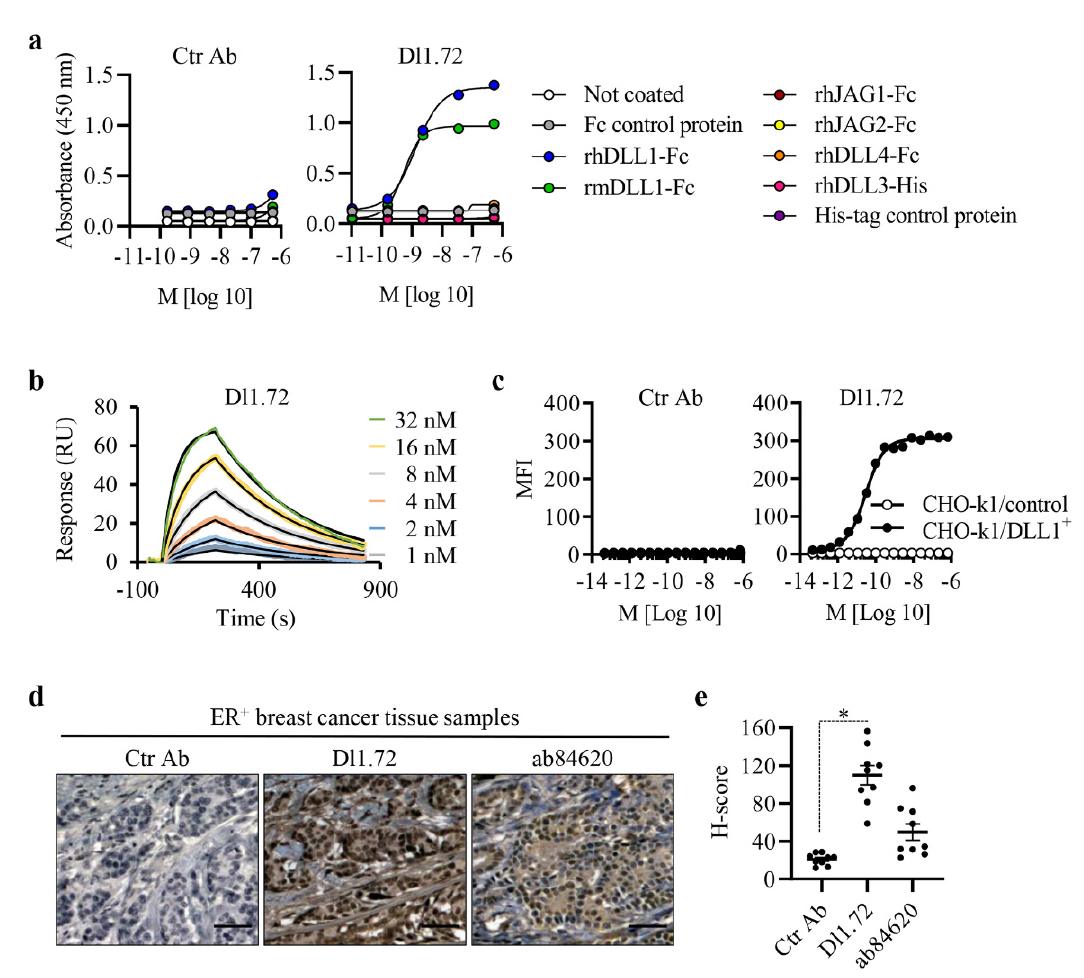
Figure 1. Anti-DLL1 Dl1.72 binding affinity and specificity to DLL1. ( a ) ELISA measuring Dl1.72 and isotope-matched negative control (Ctr Ab) binding to recombinant human (rh) Notch ligands rhDLL1-Fc, rhDLL3-His, rhDLL4-Fc, rhJAG1-Fc and rhJAG2-Fc, and murine DLL1 (rmDLL1). Uncoated wells and wells coated with Fc protein or an unrelated His-tag protein were used as negative controls. ( b ) Surface plasmon resonance was used to determine the Dl1.72 binding affinity to rhDLL1 (without Fc portion). Representative curves from one assay run with three technical replicates are shown. RU, response units. ( c ) Binding of Dl1.72 to cell surface DLL1. CHO-k1 cells overexpressing rhDLL1 on the cellular surface (CHO-k1/DLL1 + , filled circles) and CHO-k1 control cells not expressing hDLL1 (open circles) were incubated with Dl1.72 or Ctr Ab, and Ab-antigen binding was determined by flow cytometry. MFI, mean fluorescence intensity. Graphs in ( a , c ) are representative of three independent assays. ( d ) Binding of Dl1.72 to human ER + BC tumor samples by IHC. Matched-tissue sections from ER + BC samples ( n = 9) were stained individually with Dl1.72 or Ctr Ab, pre-conjugated with HRP, or with the commercial anti-DLL1 polyclonal ab84620 followed by anti-rabbit HRP-conjugated secondary antibody as a control for DLL1 detection and tissue distribution. Representative IHC images from matched samples at disease stage T1 are shown. Brown color indicates DLL1 staining and blue nuclei counterstaining with hematoxylin. ( e ) Quantification of the mean value ( ± SEM) of each immunoreactive score. Scale bars, 50 µ m. *, p < 0.05 (Mann–Whitney test).